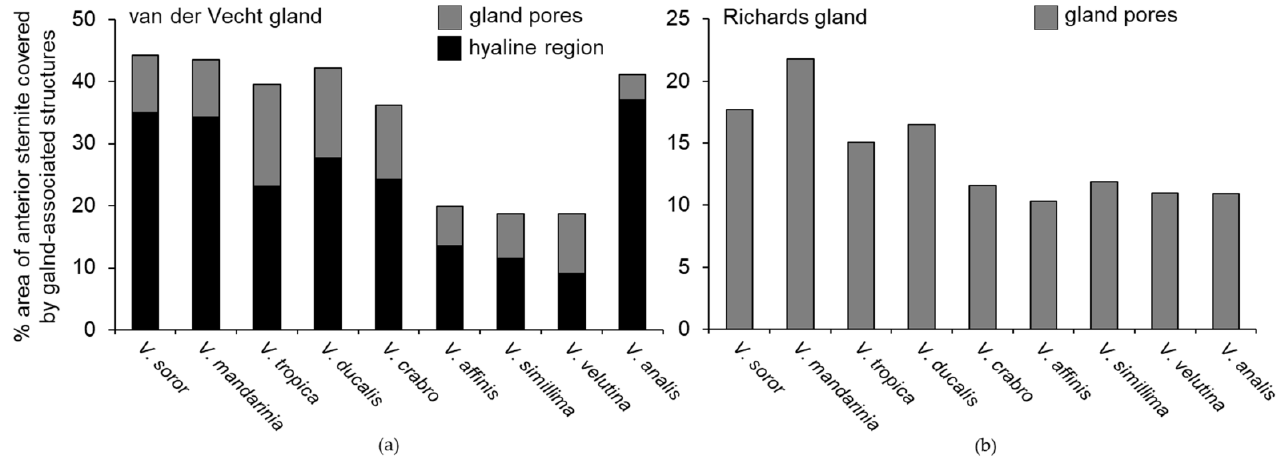
Figure 5. Gland area relative to sternite size across Vespa species. Species are presented in the order in which they appear in the phylogeny depicted in Figure 1. ( a ) Percentage of the total surface area of the anterior cuticle of the sixth metasomal sternite that was covered by gland-associated structures of the van der Vecht gland, which includes area of the paired pore clusters added to the area of the hyaline region with the sternal brush. ( b ) Percentage of the anterior of the fifth metasomal sternite that was covered by the band of pores of the Richards gland.